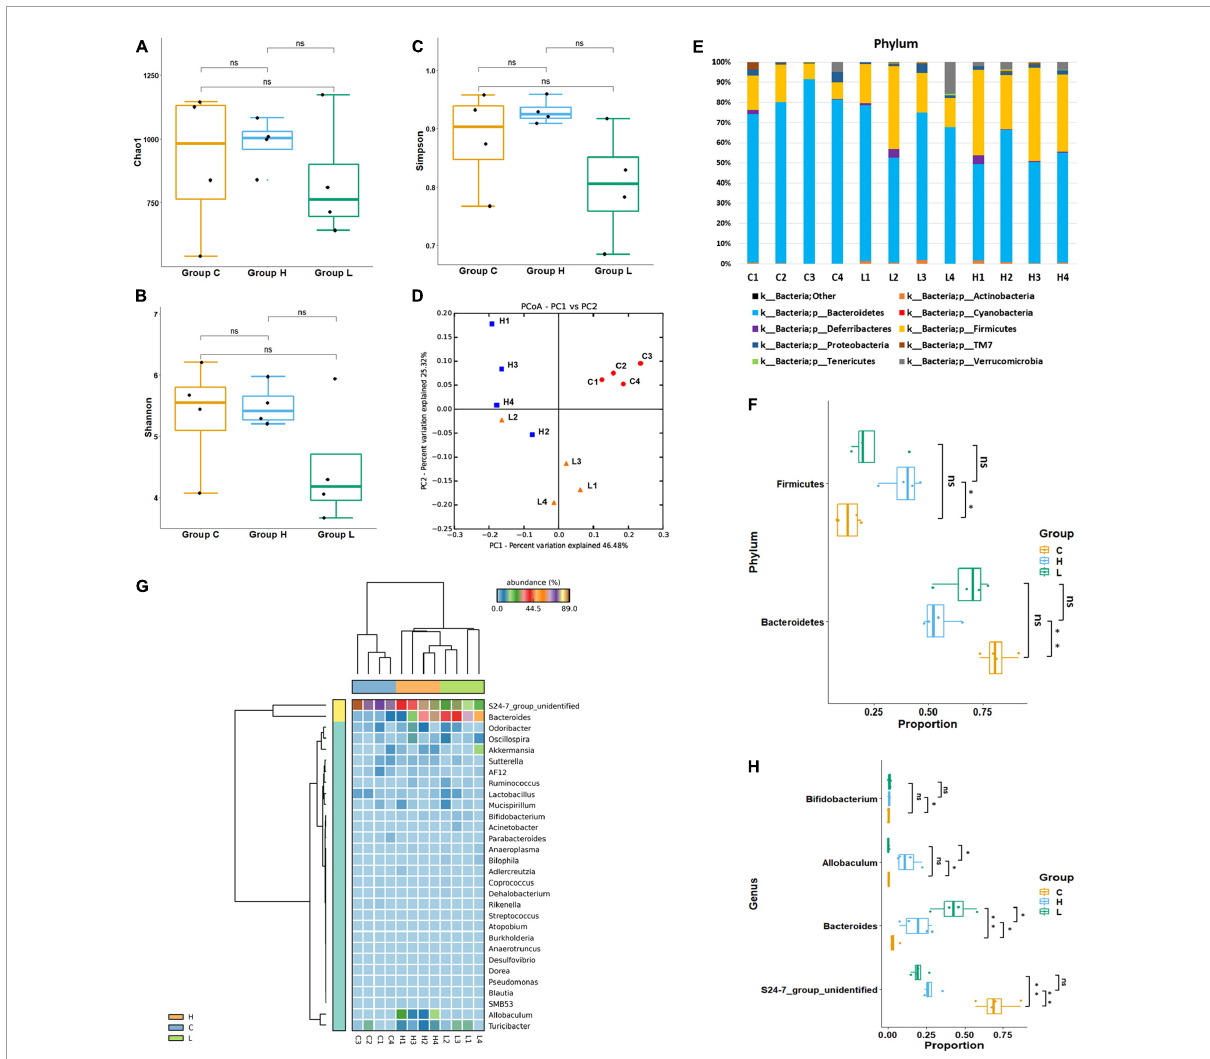
FIGURE3 Diversity and abundancy analysis of gut microbiota. (A) Boxplots of Chao1 Richness Index. (B) Boxplots of Shannon Diversity Index. (C) Boxplots of Simpson Diversity Index. (D) PCoA plot of Group C, Group L, and Group H, showed a significant difference between health, colorectal inflammation, and colorectal cancer. (E) Relative abundance of microbial communities at phylum level. The relative abundance is defined as a percentage of the total microbial sequences in a sample. (F) Boxplots of significantly changed floras at phylum level. (G) Heat map of the 37 most abundant genera at genus level. (H) Boxplots of significantly changed floras at genus level. ns: p > 0.05, no significance. ∗ p ≤ 0.05; ∗∗ p ≤